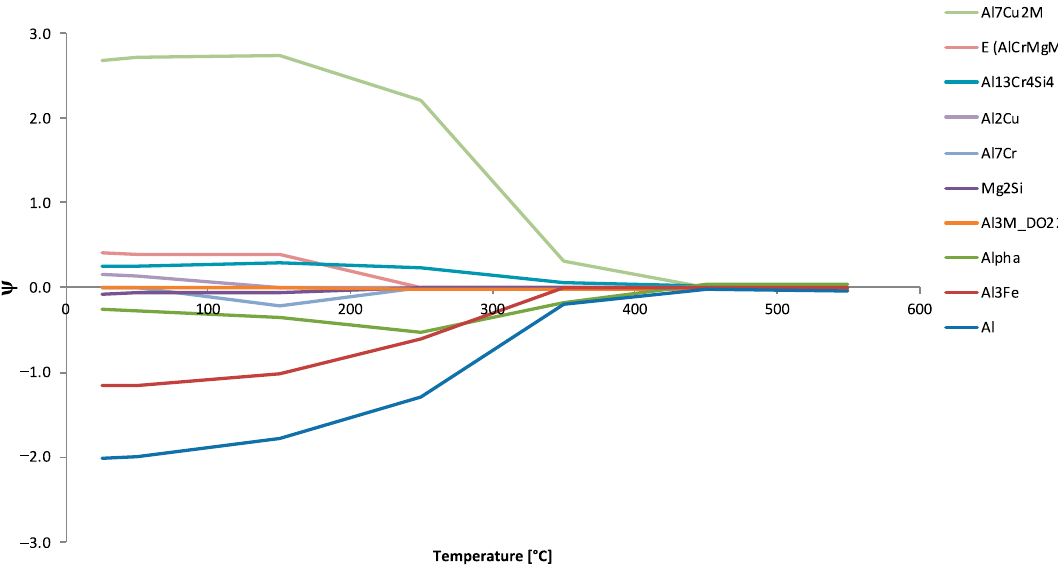
Figure 22. Plots the particular 𝜓 s for the specific alloying element copper for all of the phases identified in Figure 22’s legend as function of equilibrium temperature.